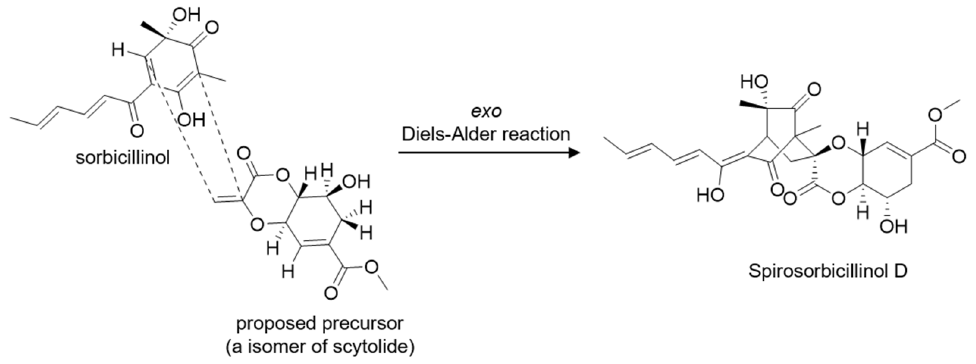
Figure 4. A biosynthetic proposal for compound 1 [31].